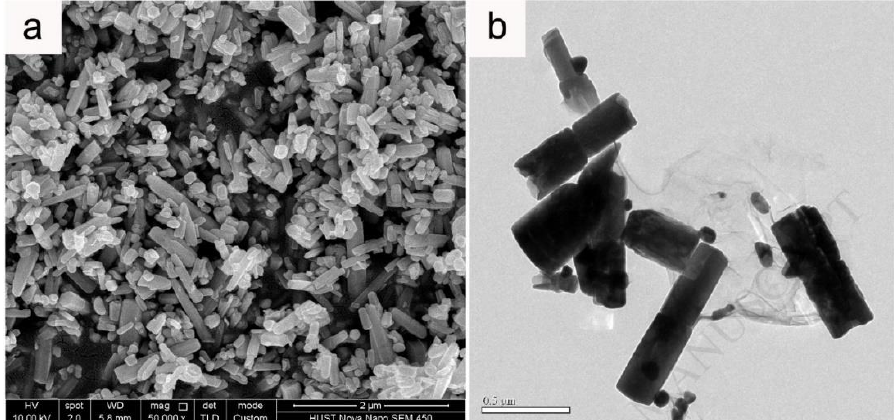
Figure 76. Images of the Ag / ZnO / graphene nanocomposites: ( a ) SEM; ( b ) TEM. Products synthesised by the microwave and ultrasonic wave combined method. Reprinted from [889], Copyright (2015), with permission from Elsevier [OR APPLICABLE SOCIETY COPYRIGHT OWNER]. All rights